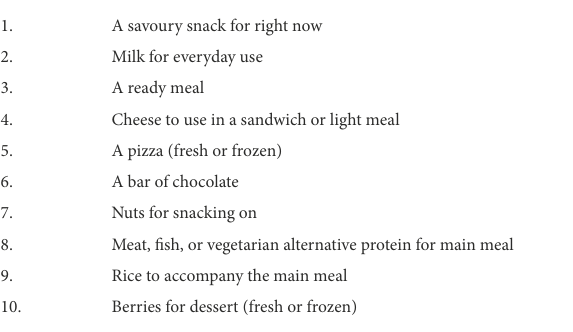
TABLE 1 Shopping list provided to participants in the online virtual supermarket